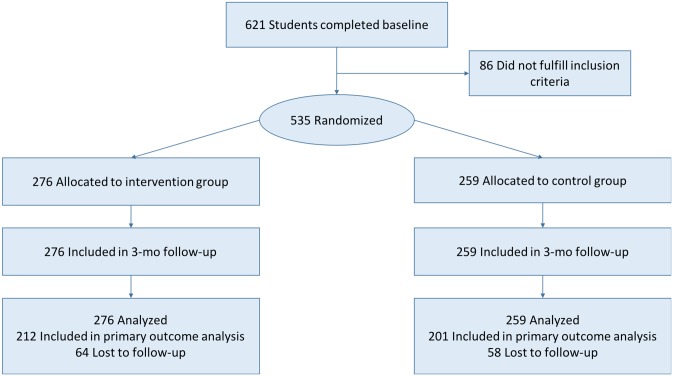
CONSORT flowchart.